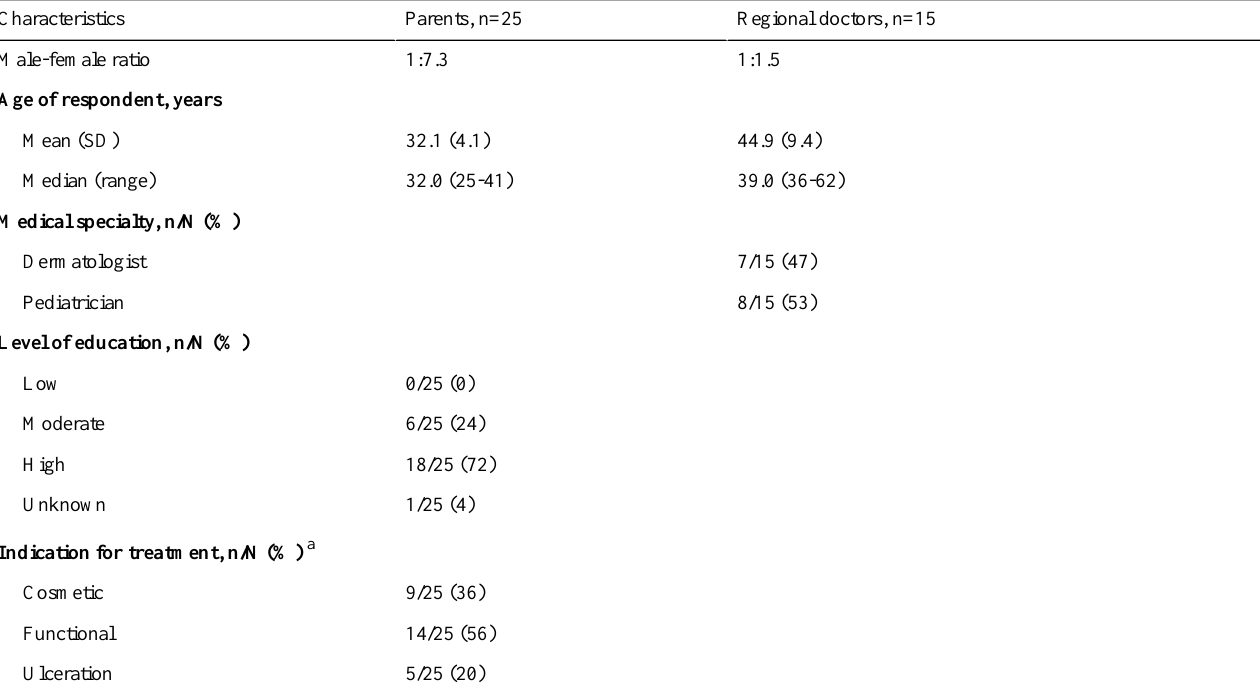
Table 2. Characteristics of the parents and regional doctors.